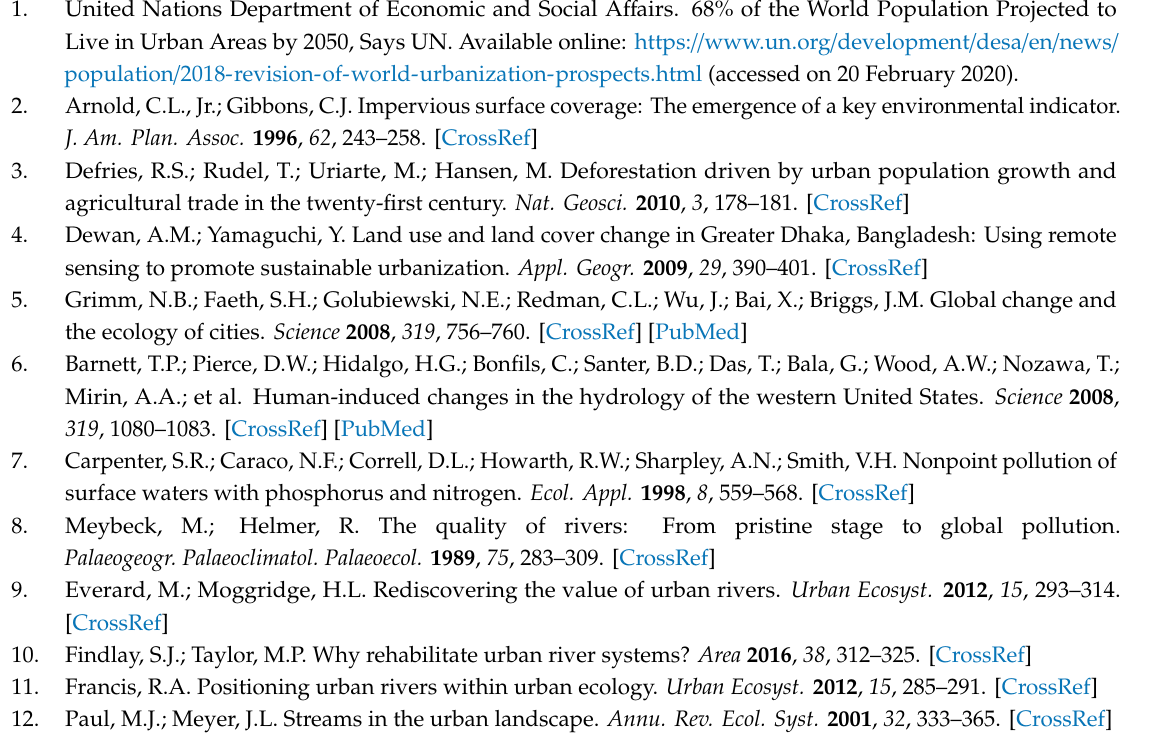
Figure S1: Matrices of the Pearson’s correlation coe ffi cient for the period 2015–2016 among 14 water quality parameters for (a) urban-dominated (URB), (b) agricultural-dominated (AGR), and (c) forest-dominated (FOR) land-cover. Water quality parameters with high factor loadings ( > 0.75) on the same factor are outlined in the same color, Figure S2: Relationships between the minimum water quality index (WQI min ) and modified WQI min from 2015 to 2018. To develop the modified WQI min , key parameter values were predicted using the established linear relationship between a key parameter and a surrogate parameter. Then, predicted values were converted into normalization factors for WQI min calculation. In the x-axis label, WQI min (COD → BOD 5 ) indicates that biochemical oxygen demand (BOD 5 ) was used as the surrogate for the key parameter of chemical oxygen demand (COD). Black dotted lines indicate 1:1 lines. Figure S3: Relationships between objective and minimum water quality indices (WQI obj and WQI min ) from 2017 to 2018. Weights were determined using two methods; for a-c, a relative weight was assigned to each key parameter and for d-f, the percent variance explained by a given extracted factor was assigned to each key parameter. Black dotted lines and blue dashed lines indicate 1:1 lines and regression lines, respectively. Table S1: Proportions of three land-cover categories (urban, agricultural, and forested land) for urban-dominated watersheds (URB), agricultural-dominated watersheds (AGR), and forest-dominated watersheds (FOR). Table S2: Parallel analysis results comparing eigenvalues and simulated mean eigenvalues for urban-dominated (URB), agriculture-dominated (AGR), and forest-dominated (FOR) land-cover. The simulated mean eigenvalue indicates the mean eigenvalue calculated from randomly generated simulation data. Asterisks (*) indicate that the eigenvalue is higher than the corresponding simulated mean